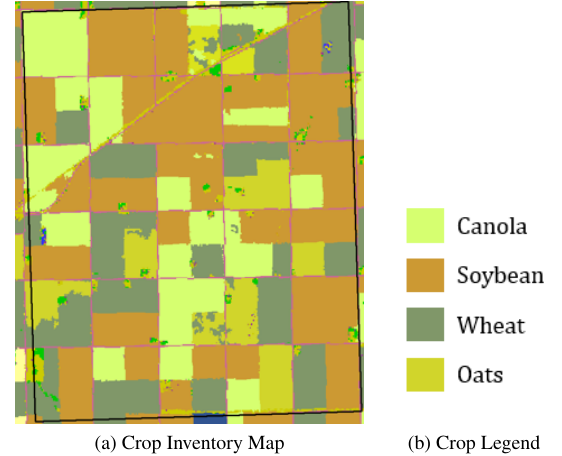
Figure 2. Crop inventory map over the test site at Carman, Canada for 2016 crop season.